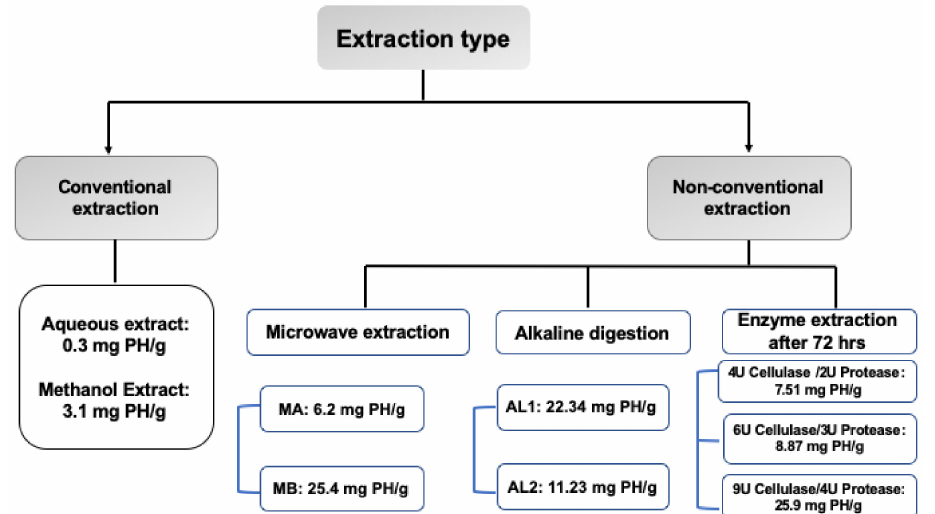
Figure 2. Diagrammatic presentation for phyllanthin yield by conventional vs. nonconventional methods. PH, phyllanthin; MA, the 80% aqueous MeOH extract; MB, the dry extract obtained after eluting MA from the Diaion HP-20 column using 50% MeOH; AL1, CH 2 Cl 2 extract of KOH-digested powder; AL2, CH 2 Cl 2 extract of NaOH-digested